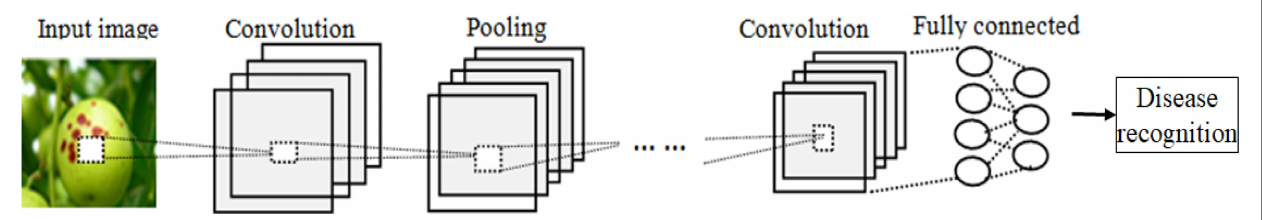
FIGURE 1 | Basic architecture of convolutional neural networks